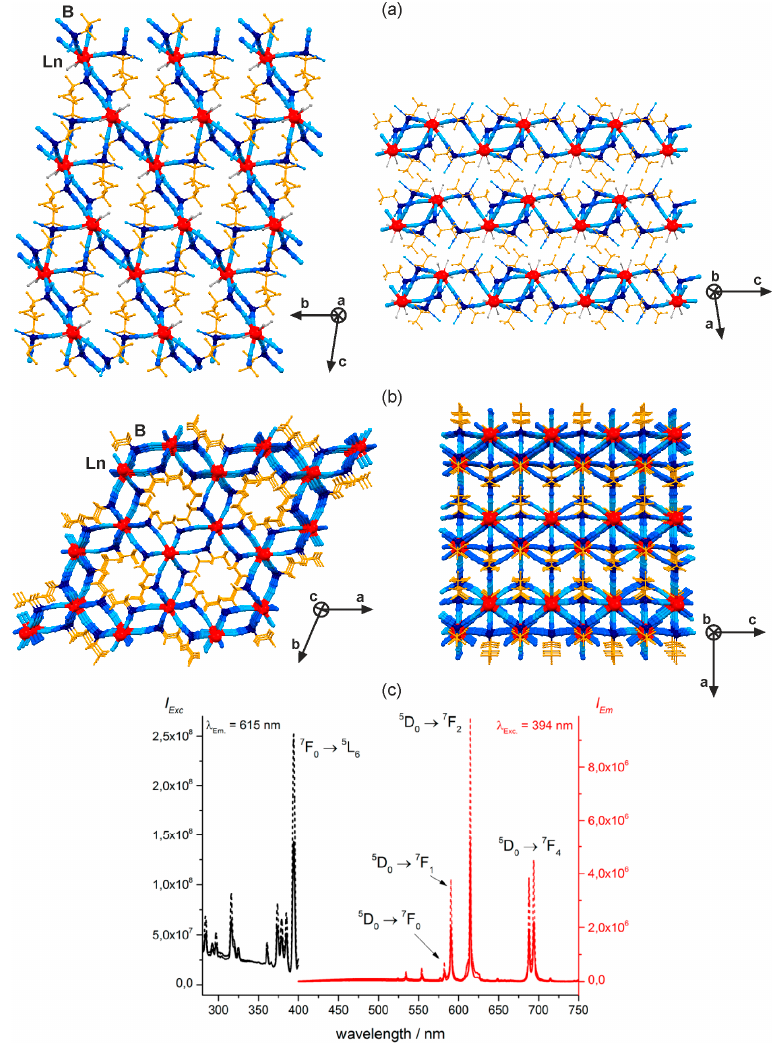
Figure 12. Crystal structure and optical properties of two-dimensional [Ln III {C 2 F 5 B(CN) 3 } 3 (H 2 O) 3 ] (Ln = La, Eu, Ho) coordination polymer ( a , c ), and the related anhydrous three-dimensional [Ln III {C 2 F 5 B(CN) 3 ] (Ln = La, Eu, Ho) coordination network ( b , c ): ( a ) the views of the single layer, and the arrangement of layers, ( b ) the views of the 3D cyanido-bridged network along c and b crystallographic axes, ( c ) the room temperature excitation and emission spectra of the 2D LnB layer (solid lines), and 3D LnB network (dotted lines). Colours for the structural diagram: Ln, red; B, dark blue; CN − , blue; C 2 F 5 − , orange; H 2 O, grey [123]. Reprinted with permission from Inorg. Chem. 2017 , 56 , 2278–2286. Copyright 2017 American Chemical Society.